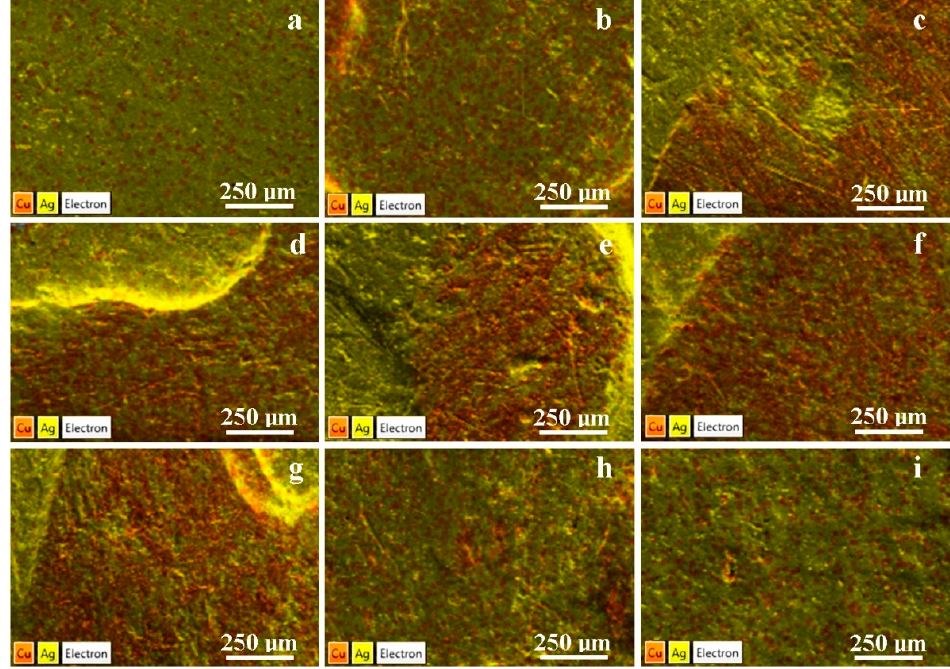
Figure 6. Elemental maps of the 3-Polker coins issued in: ( a ) 1619, ( b ) 1620, ( c ) 1621, ( d ) 1622, ( e ) 1623, ( f ) 1624, ( g ) 1625, ( h ) 1626, and ( i ) 1627. ( f ) 1624, ( g ) 1625, ( h ) 1626, and ( i )